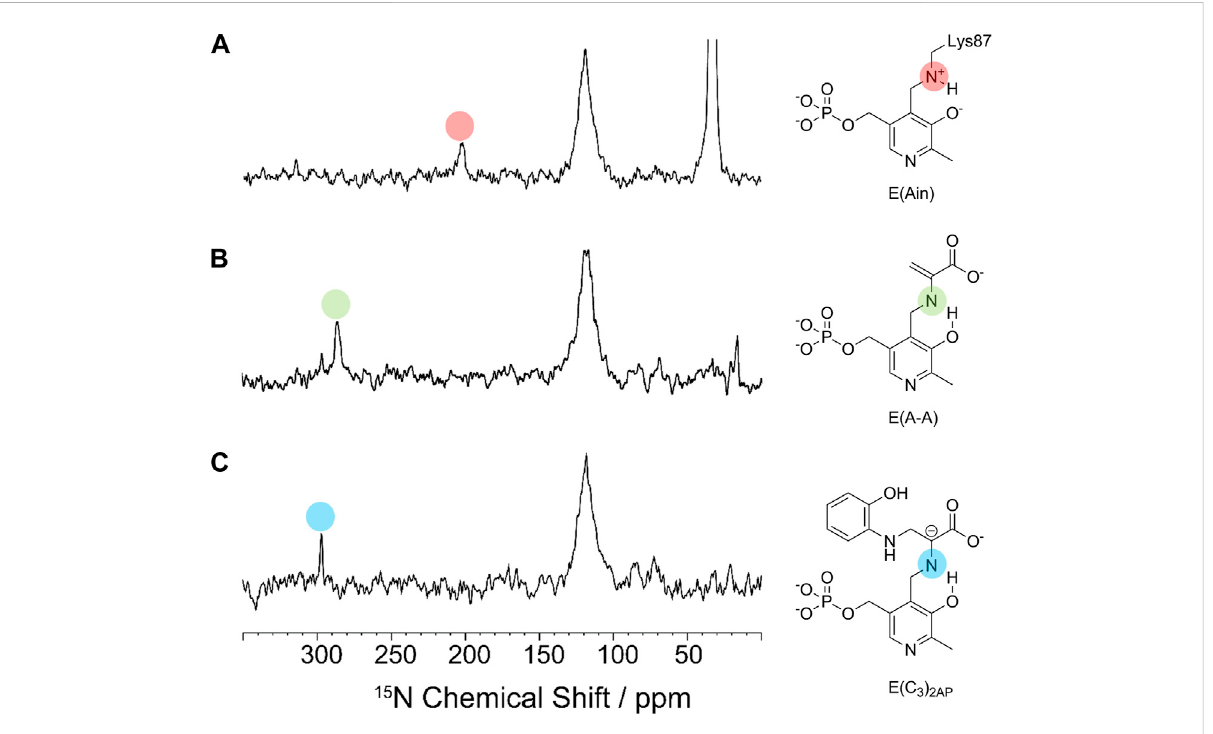
FIGURE 7 15 N CPMAS spectra of (A) E(Ain), (B) E(A – A) and (C) E(C 3 ) 2AP . The indole analogue 2-aminophenol (2AP, 12 ) reacts with E(A – A) to give a quasi-stable carbanion intermediate, E(C 3 ) 2AP , that turns over slowly to yield the corresponding new amino acid analogue of L-Trp (Ferrari et al., 2001). Spectra acquiredat9.4 Tand8 kHzmagic-anglespinning(MAS)at − 10 °